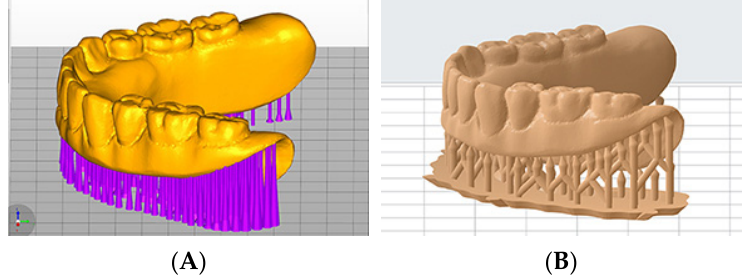
Figure 1. Printing settings for two types of printers. ( A ) Printing setting for DLP printer. ( B ) Printing setting for SLA printer.